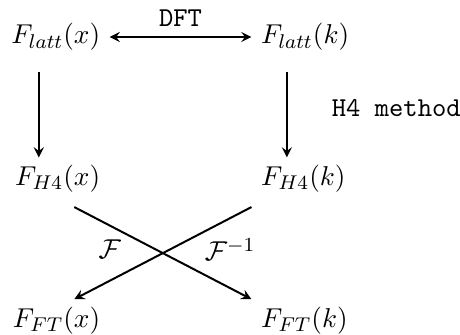
Figure 3. Schematic representation of the definition of propagators via Fourier transforms in the continuum of the H4-extrapolated data. Starting from the lattice propagators that are the one the discrete Fourier transform (DFT) of the other, the method proposed obtains the H4-extrapolated propagators. If the method removed all lattice artifacts (both discretization and finite volume ones), the continuous Fourier transform obtained through the numeric integration in eq. (4.2), F ( x ) , FT and the extrapolated data in position space, F ( x ) , would coincide, and the same can be said H 4 about momentum-space